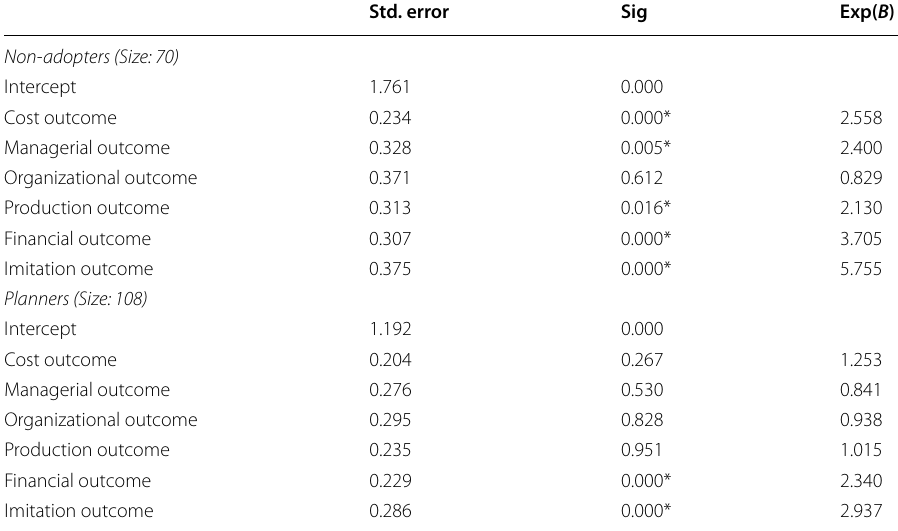
Table 8 Multinomial analysis